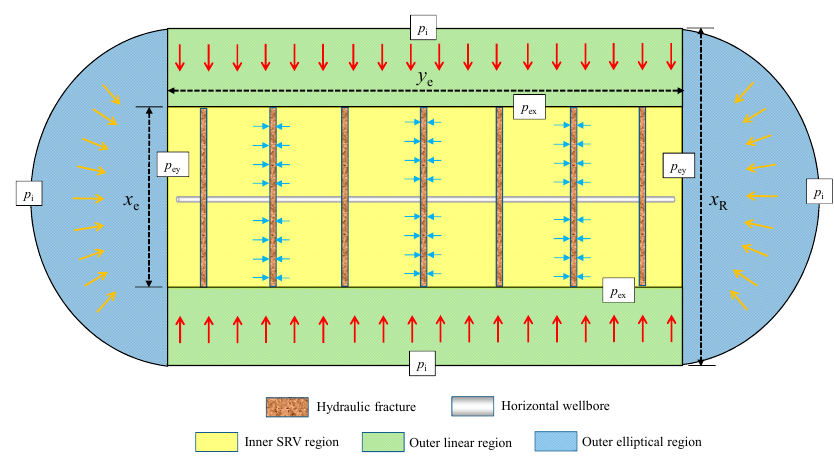
Figure 2. Schematic of the compound elliptical-flow model representing four contiguous regions for a multiple-fractured horizontal well (MFHW). SRV, stimulated rock volume.